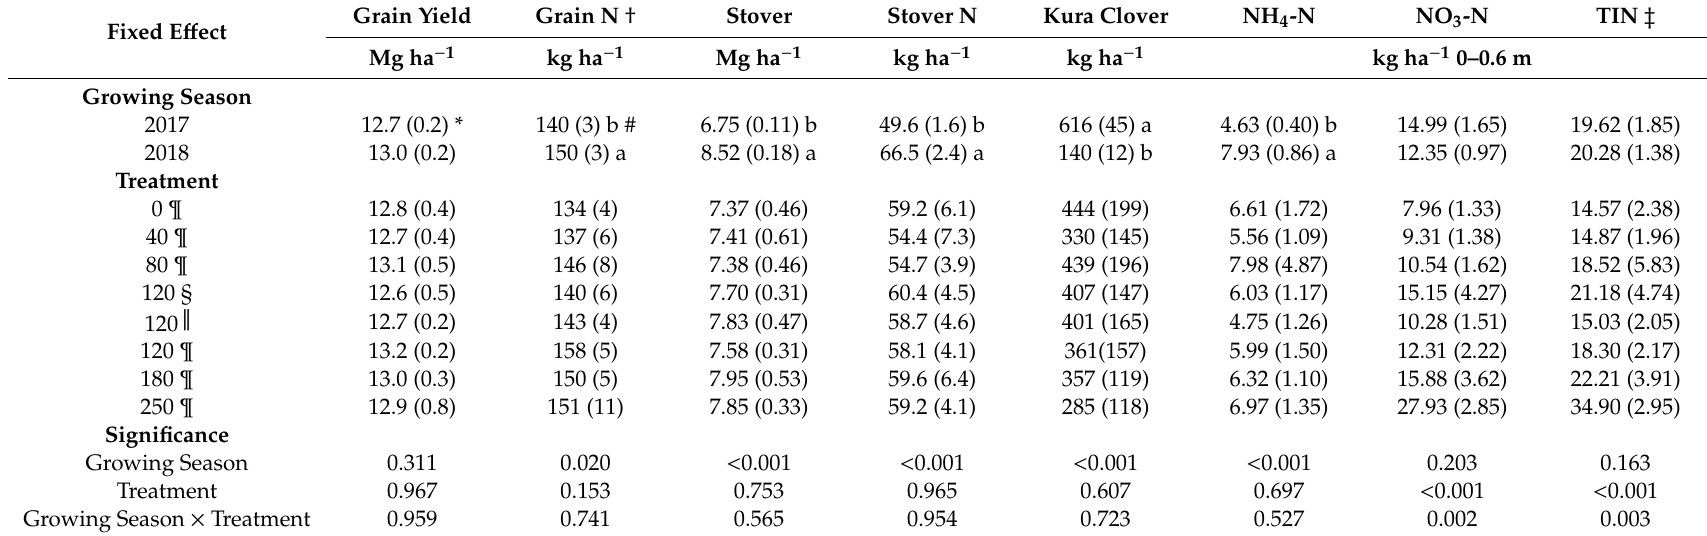
Table 2. Growing season and treatment means, standard error, and statistical significance of dependent variables for first-year maize. Fixed E ff ect Grain Kura Grain N † Stover Stover N Yield Clover